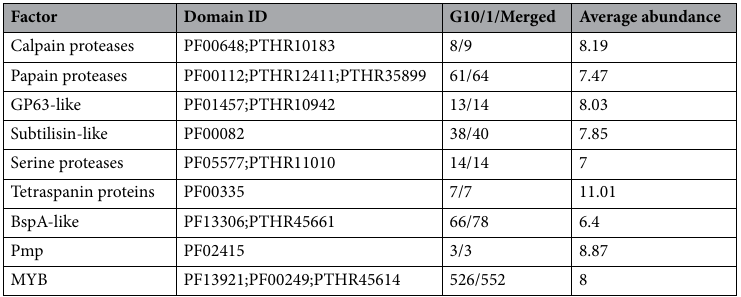
Table 2. Summary of the analyzed factors. Columns are composed as follows, (1) adaptative and virulence factors analyzed in this work; (2) identifiers corresponding to PFAM and PANTHER databases; (3) count number of transcripts in G10/1 transcriptome with FPKM > 1 and total factors identified in merged transcriptome; (4) log